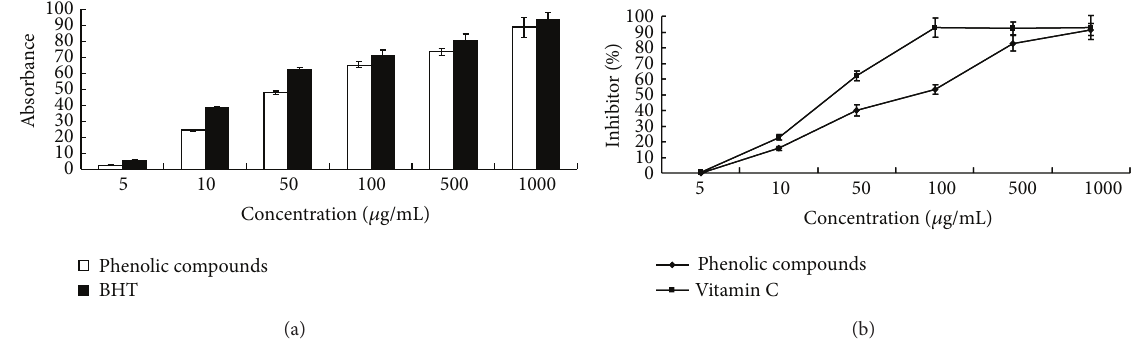
Figure 1: (a) Reductive ability of EFP and BHT. (b) DPPH radical scavenging effect of EFP and vitamin C.